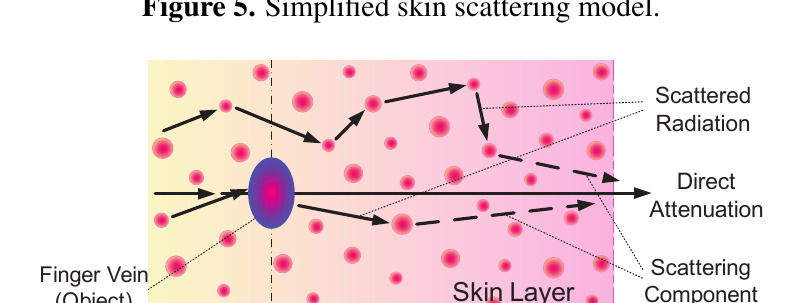
Figure 5. Simplified skin scattering